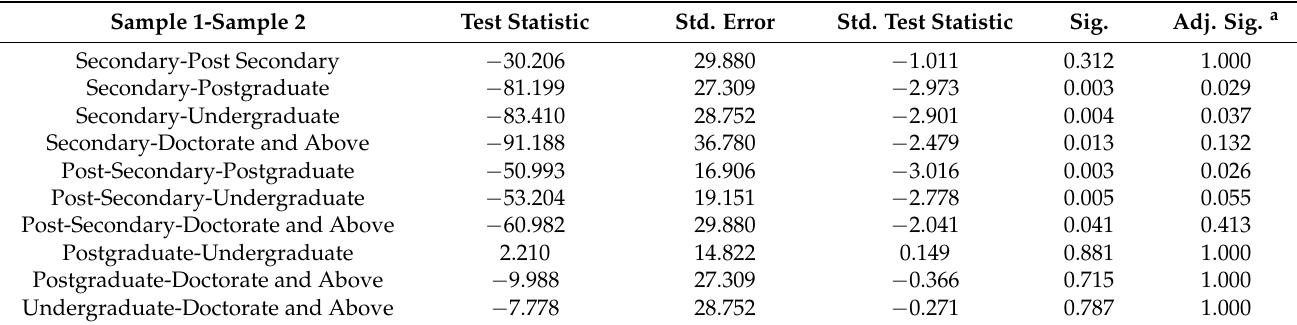
Table 12. Post hoc analysis—art damage, deterioration and loss.